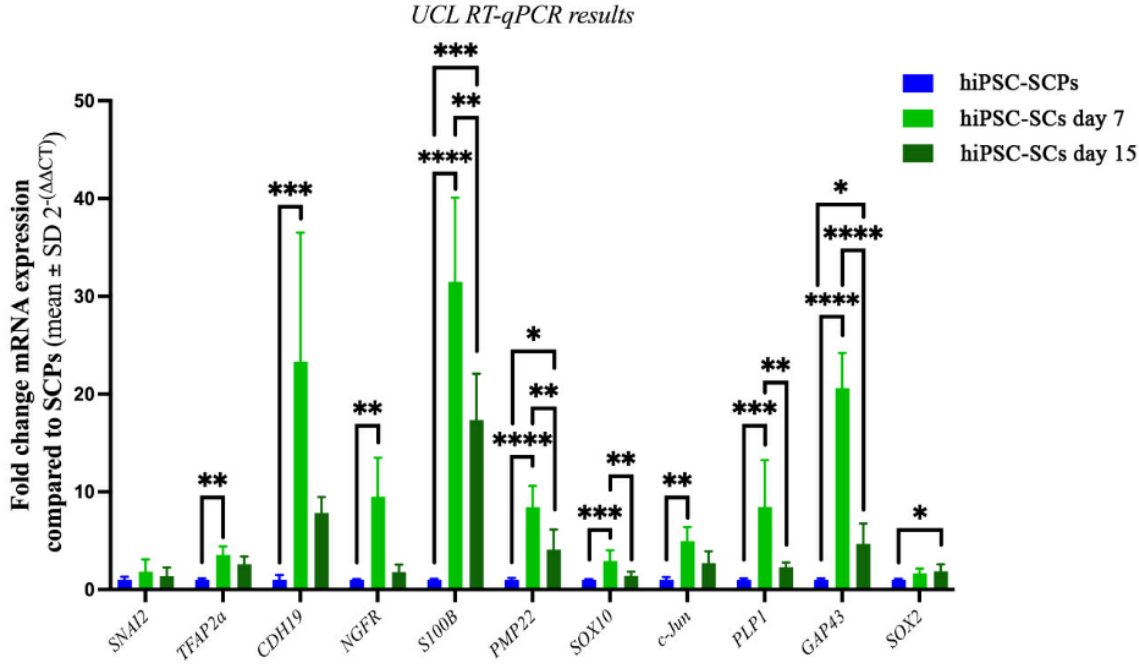
Figure 8. UCL RT-qPCR results showing fold change in mRNA expression in hiPSC-SCs after 7 (light green) or 15 days in SCDM (dark green) compared with hiPSC-SCPs (blue), which was set at 1. Shapiro – Wilks normality test followed by either one- way ANOVA with Tukey’s post -comparison